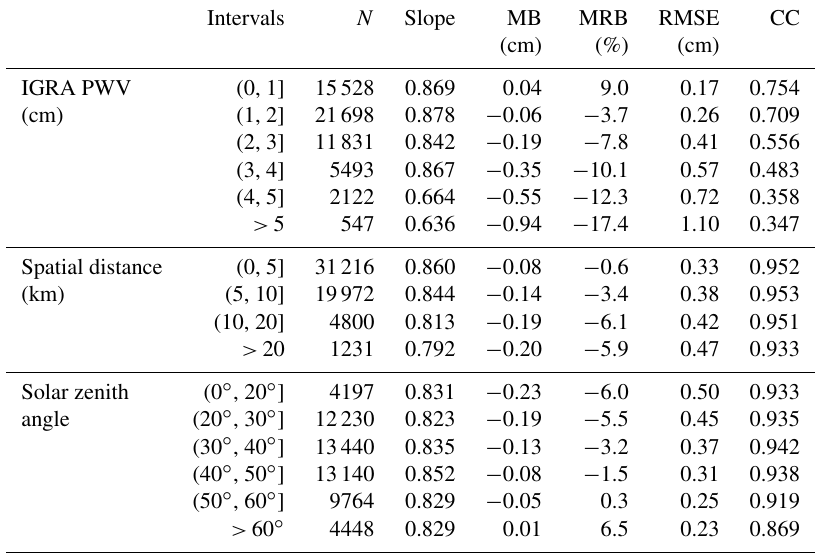
Table 3. Statistics of the global evaluation of MERSI-II PWV in different PWV and distance ranges. Intervals N Slope MB MRB